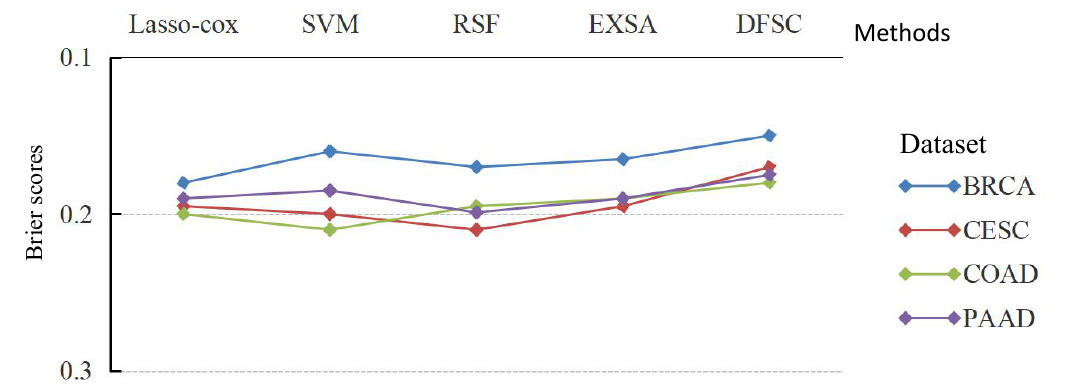
Figure 3. Average brier score achieved by learning model (lower is better) over multiple different train/test splits of each